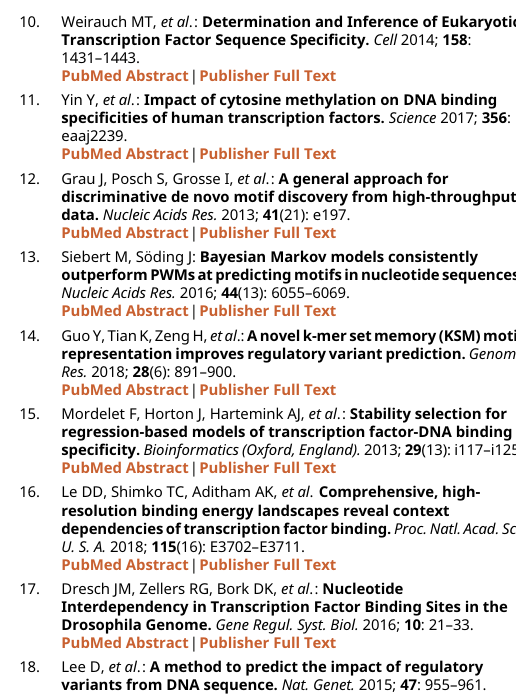
(cid:129) Supplementary figure S1 (Performance of Δ PWM CIS-BP in predicting weak and strong TF binding sites.)